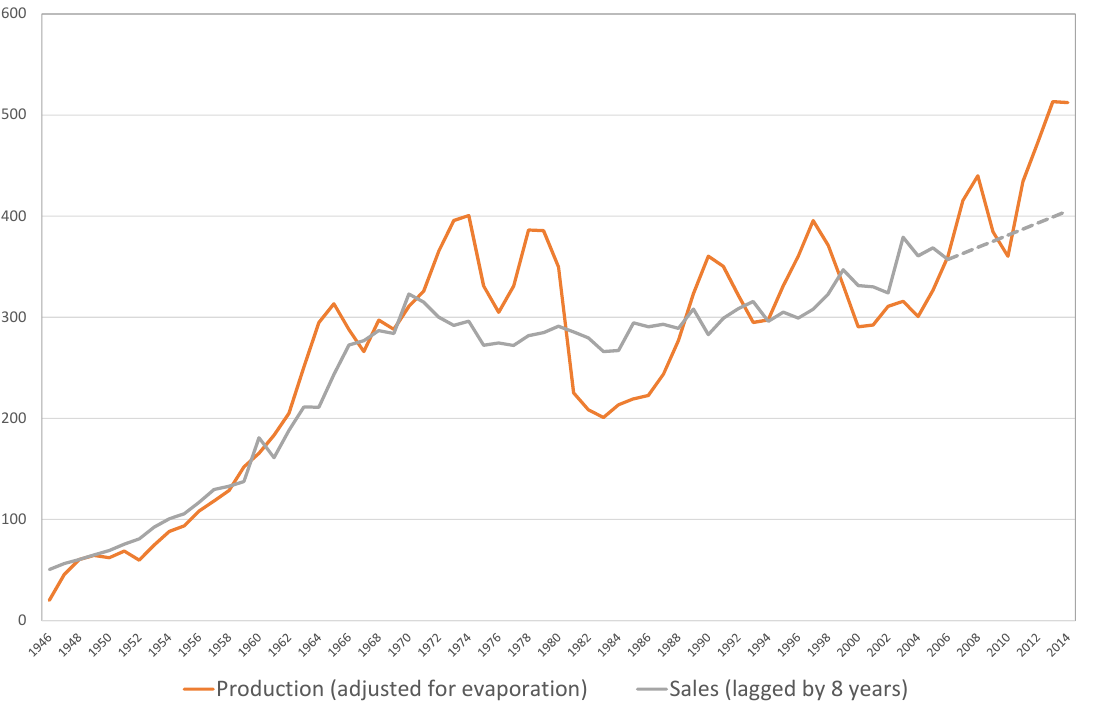
Figure 4. The Scotch whisky stock cycle. Annual totals in mlpa. Constructed from SWA statistics and The making of Scotch whisky as outlined above, assuming 16% of production is lost to evaporation on a straight line basis for an average maturation age of 8 years.